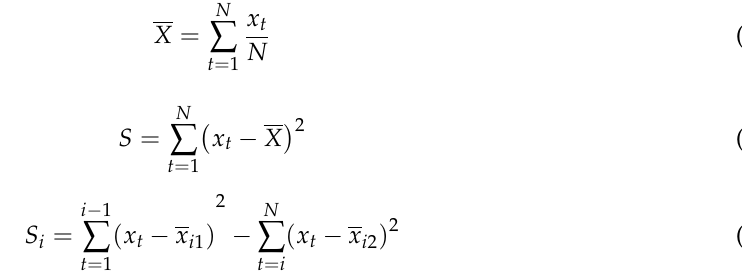
Figure 2. Mean grid river density of the study area in different grid sizes. Grid size increased from 1.0 km to 10.0 km in 0.5 km increments. The relationship between mean grid river density (GRD) and grid size was well fitted by the power function at each time.